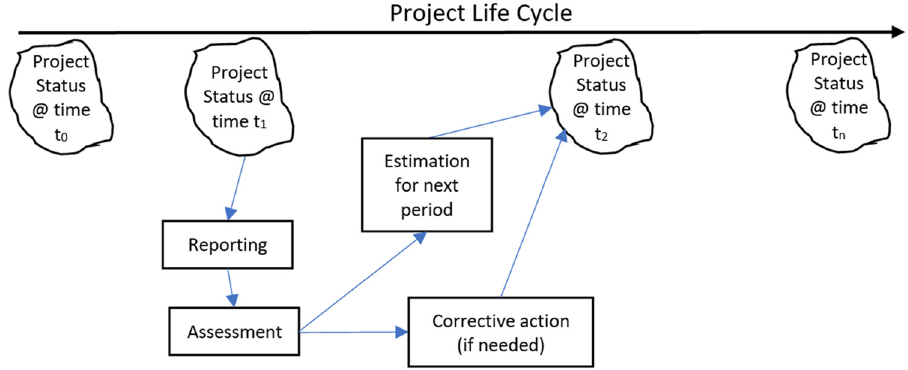
Figure 5: Role of project assessment during project life cycle.